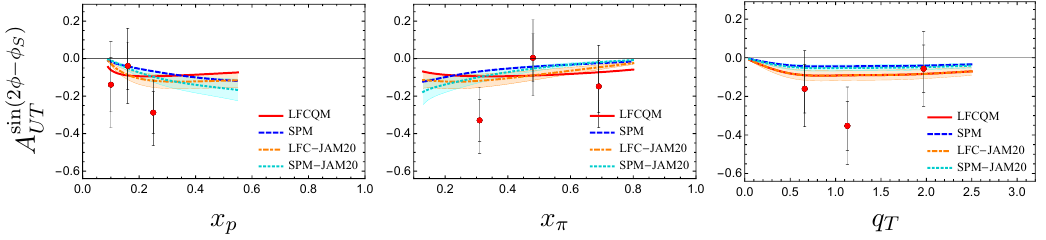
Figure 6 . A sin(2 (cid:30) (cid:0) (cid:30) S ) as a function of x p (left), x (cid:25) (middle) and q T (right) vs COMPASS data [46]. UT